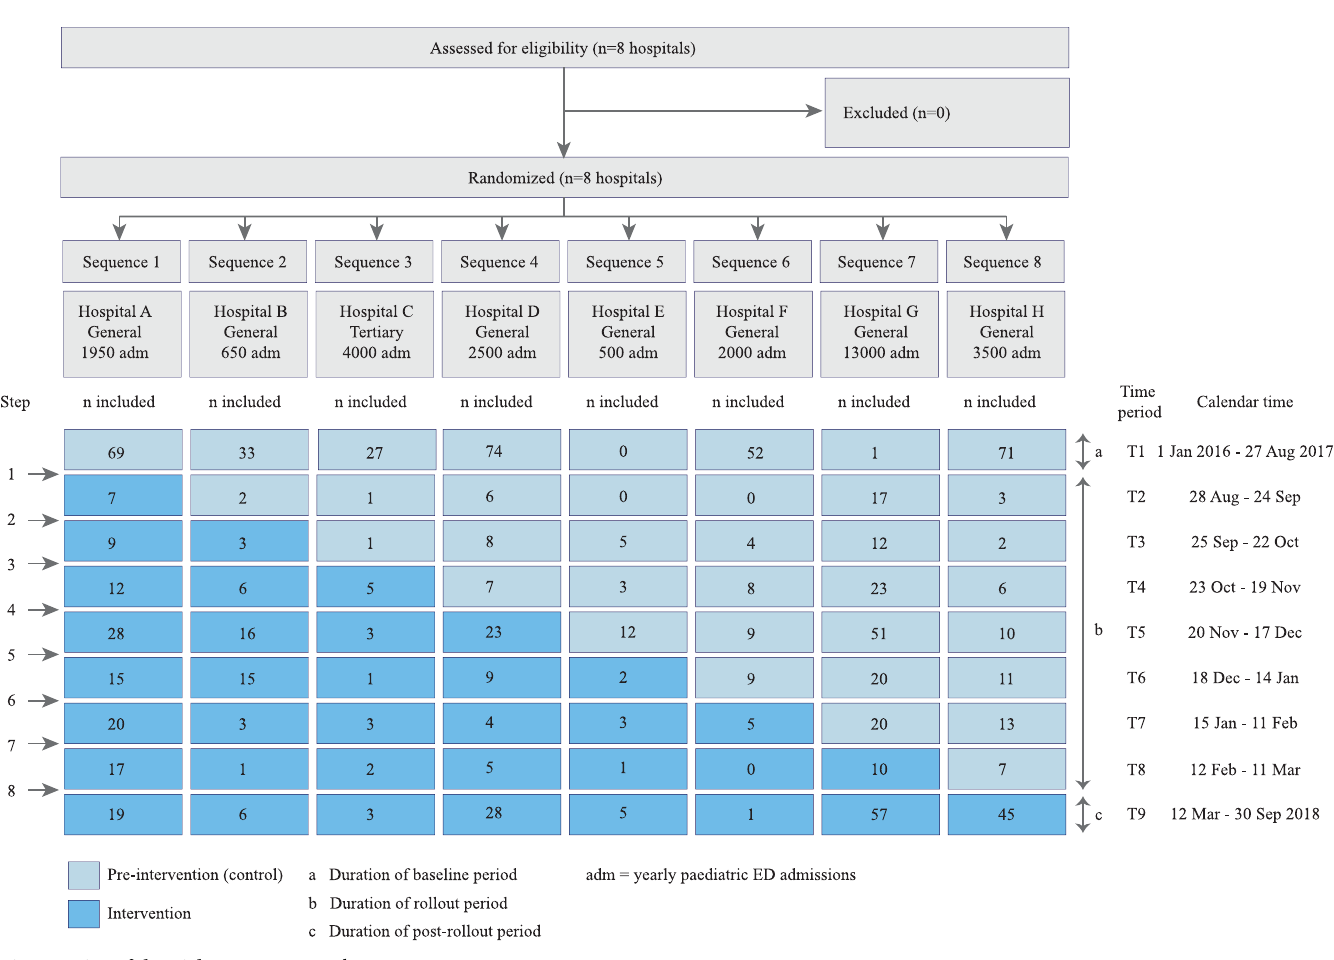
Fig 1. Design of the trial. ED, emergency